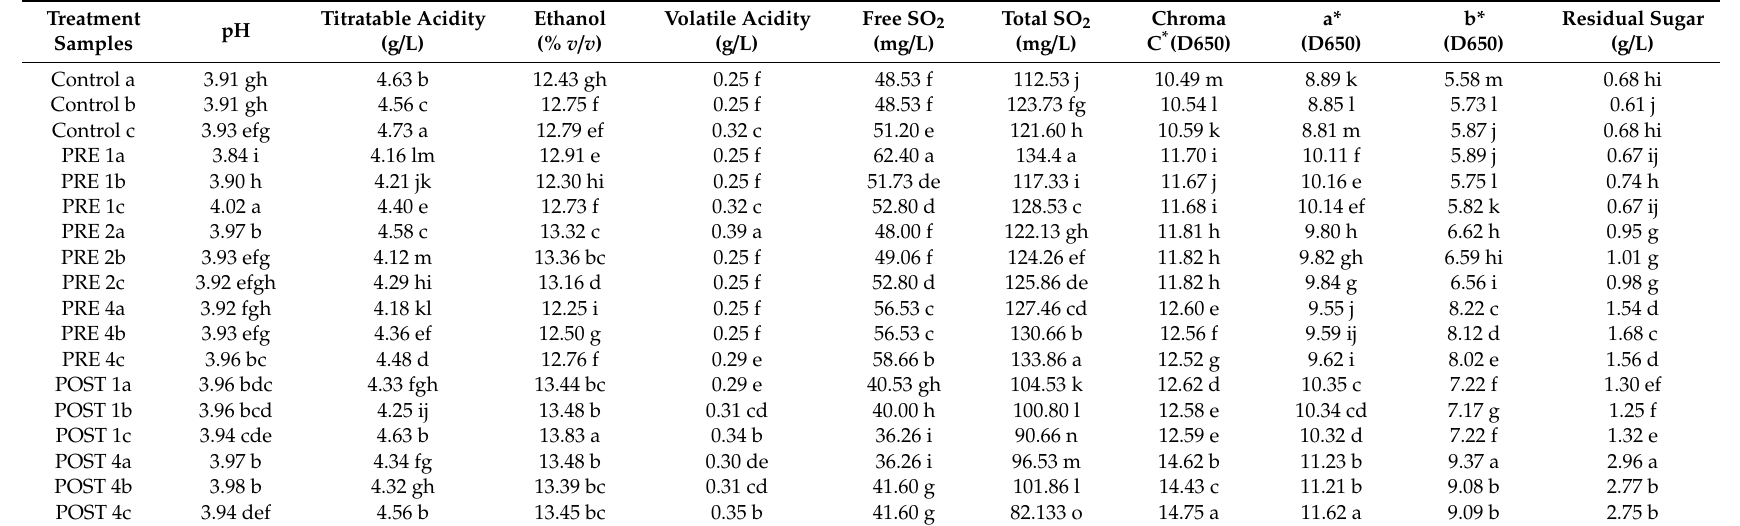
Table 1. Basic chemical composition of the GL wines from 28 L